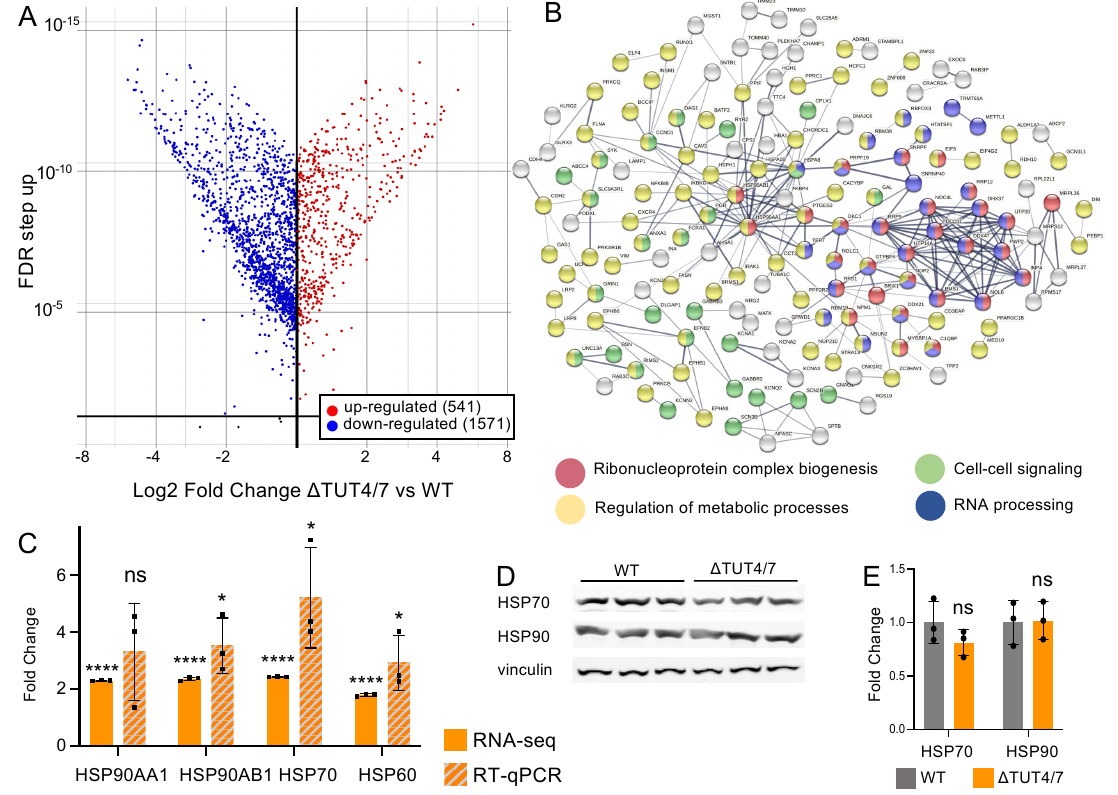
(Figure 3B) [29]. We also analysed the mRNA datasets using gene ontology (GO) analysis to identify biological processes and molecular functions impacted by the TUT4/7 deletion (Table S8) [47,48]. We found most of these overabundant transcripts are involved in regula- tory pathways, with specific clusters belonging to ribonucleoprotein complex biogenesis (Figure 3B, red, strength 0.53), regulation of metabolic process (Figure 3B, yellow, strength 0.12), cell–cell signaling (Figure 3B, green, strength 0.27), and RNA processing (Figure 3B, blue, strength 0.29) (detailed in Table S8). These data show that TUT4/7 control gene abundance in many cellular processes and are global regulators of mRNA homeostasis in mammalian cells. Fig. 3